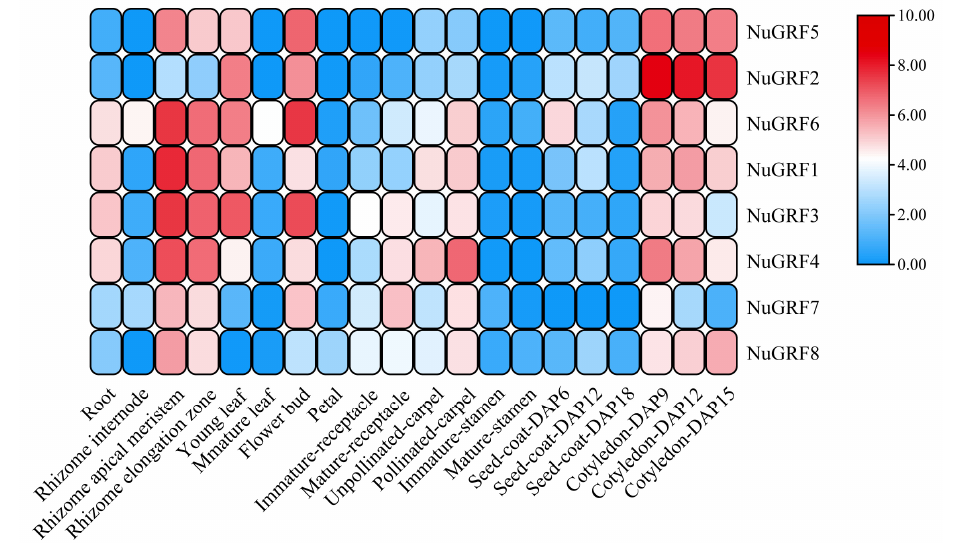
Figure 6. Expression heat map of NuGRFs in N. nucifera . Seed-coat-DAP6, 6-day seed coat; Seed-coat-DAP12, 12-day seed coat; Seed-coat-DAP18, 18-day seed coat; Cotyledon-DAP9, 9-day cotyledon; Cotyledon-DAP12, 12-day cotyledon; Cotyledon-DAP15, 15-day cotyledon. The color scale at the right of the heatmap refers to the relative expression level, and the color gradient from faint yellow to dark blue represents increasing expression level.